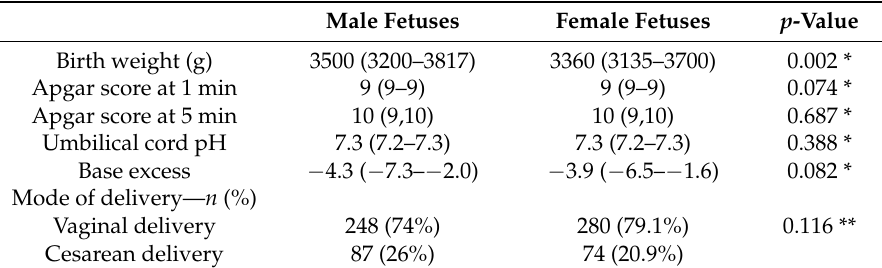
Table 3. Neonatal outcome according to fetal